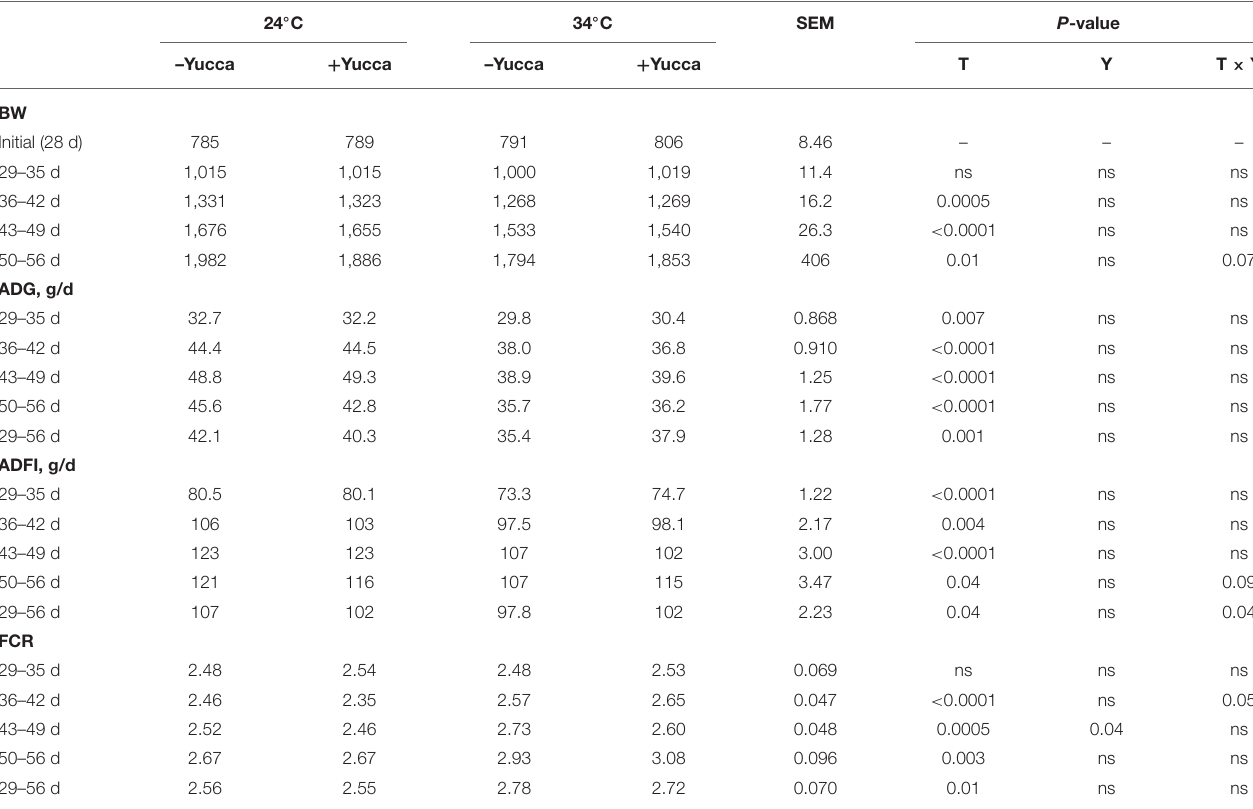
TABLE 3 | Effects of high ambient temperature and yucca on the growth performance of broiler chickens. 24 ◦ C 34 ◦ C SEM P